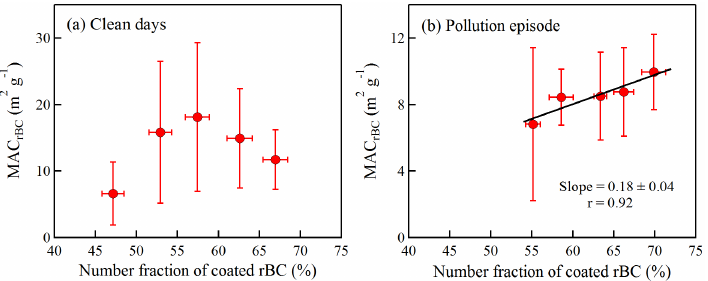
Figure 7. Mass absorption cross section of rBC (MAC rBC ) versus number fraction of coated rBC during (a) clean days and (b) the pollution episode. The error bars correspond to the standard deviations of MAC rBC and number fraction of coated